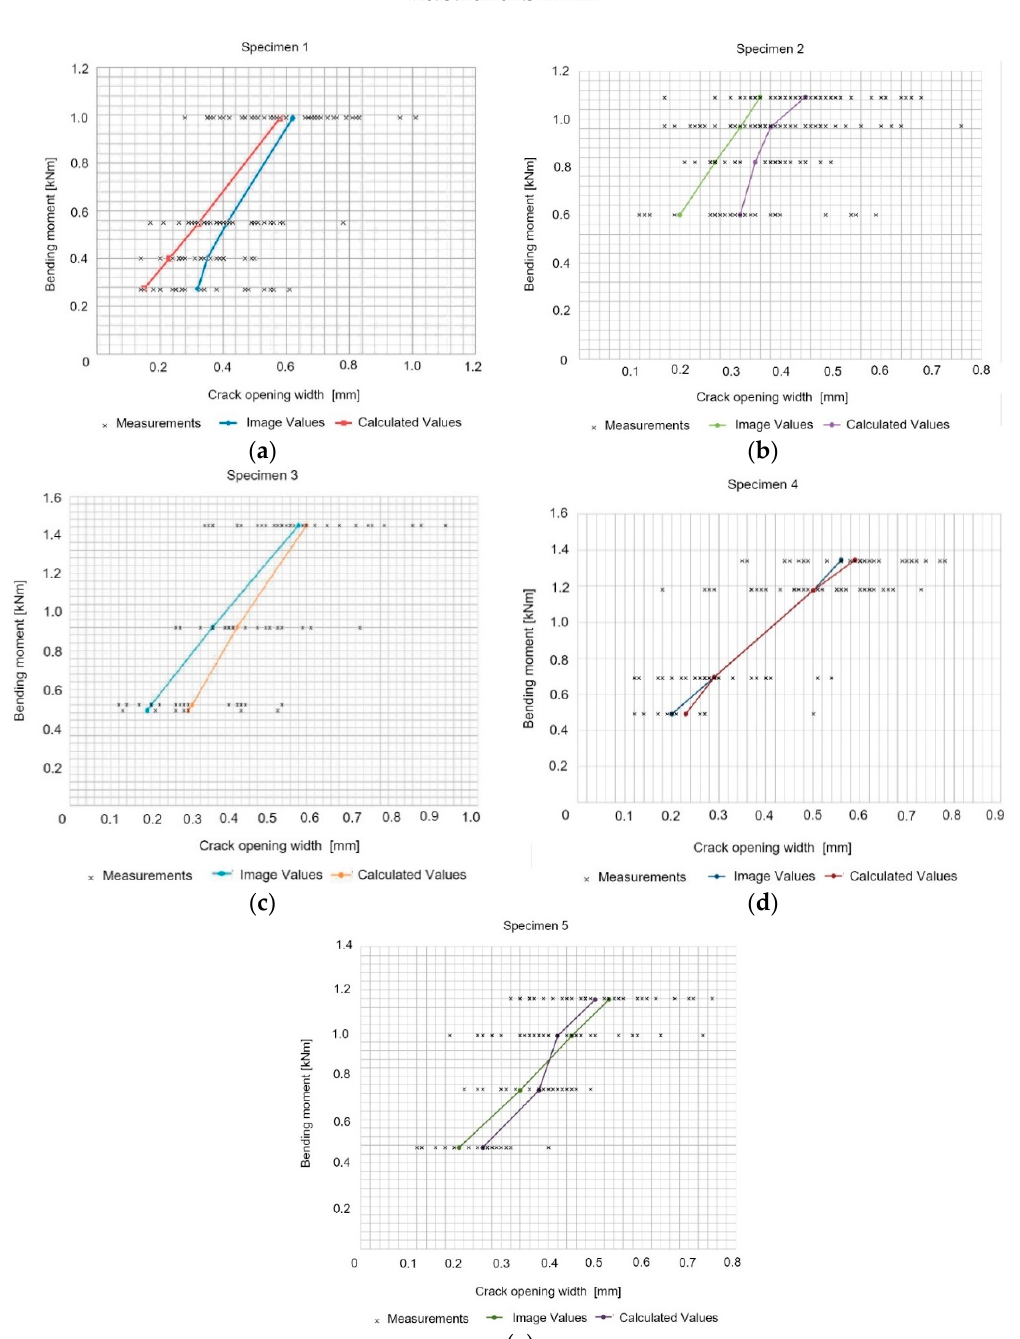
Figure 20. Measured and calculated values for crack opening width: ( a ) Specimen 1; ( b ) Specimen 2; ( c ) Specimen 3; ( d ) Specimen 4; and ( e ) Specimen 5.